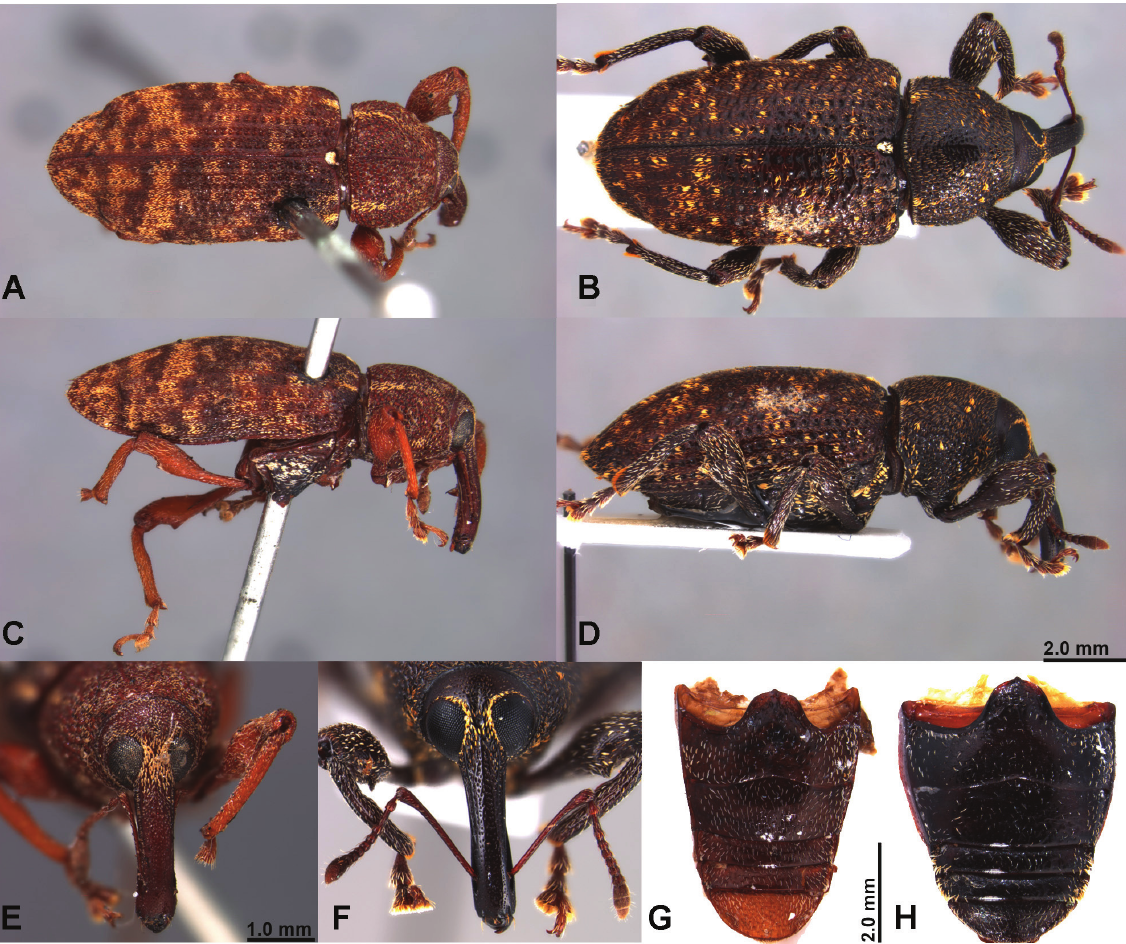
Fig. 1. A, C, E, G. Heilipodus huguenini (Reitter, 1891) comb. nov., holotype. A . Habitus dorsal. C . Habitus lateral. E . Head and rostrum. G . Ventrites. — B, D, F, H. Heilipodus goeldii sp. nov. paratype,